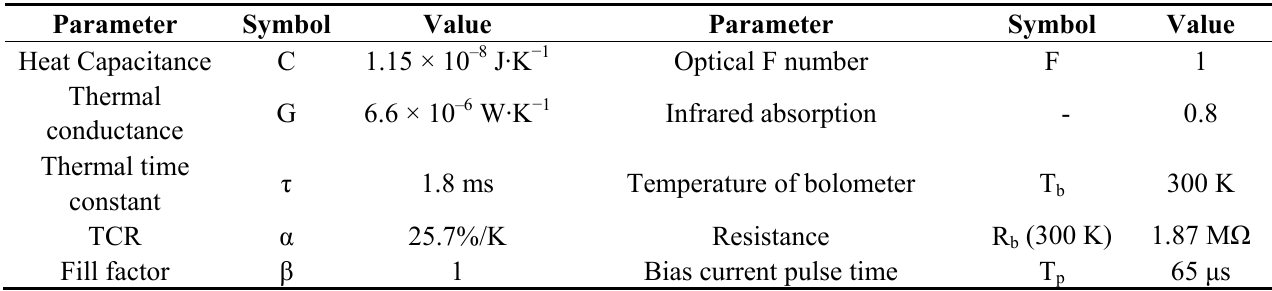
Table 2. Assumed parameters for the proposed protein microbolometer.